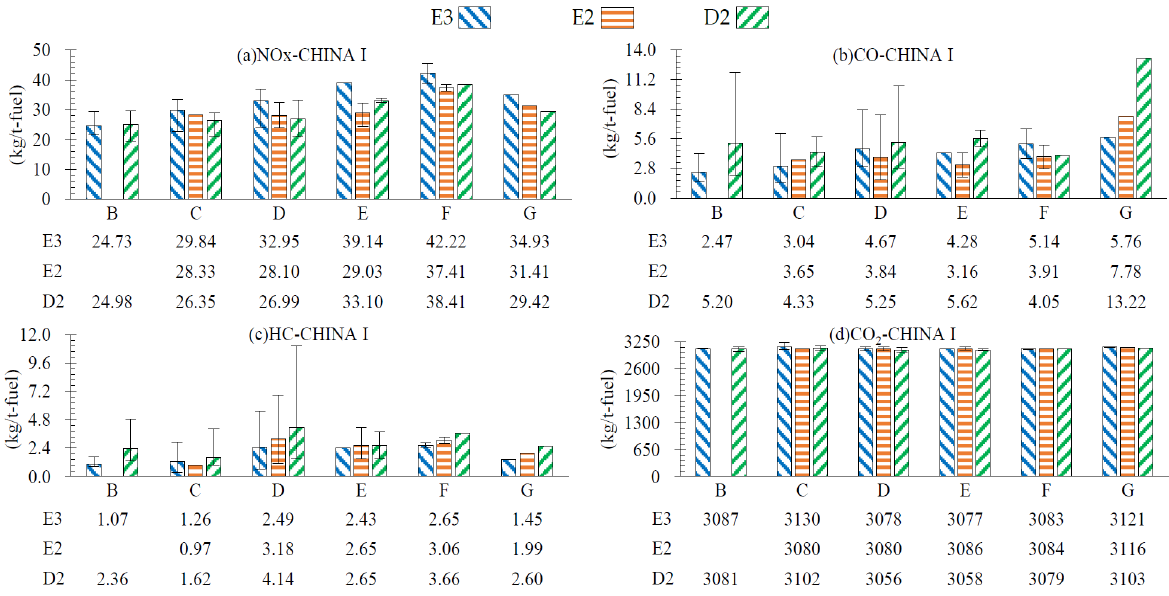
Figure 2. Fuel-based emission factors for different single-cylinder displacements under the CHINA I standard. ( a ) NOx-specific emissions in the E3, E2, and D2 cycles; ( b ) CO-specific emissions in the E3, E2, and D2 cycles; ( c ) HC-specific emissions in the E3, E2, and D2 cycles; ( d ) CO 2 -specific emissions in the E3, E2, and D2 cycles.